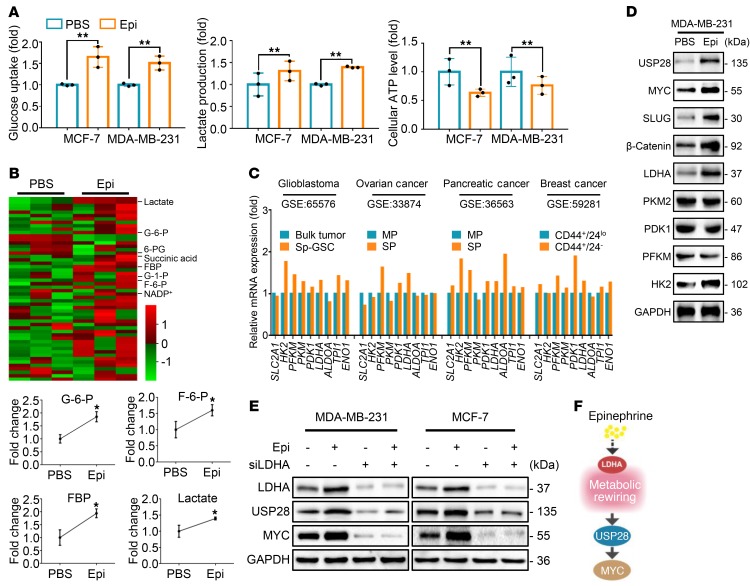
Chronic stress elevates LDHA to enhance glycolysis.(A) Glucose uptake, lactate production, and cellular ATP were measured in MCF-7 and MDA-MB-231 cells treated with PBS or Epi for 5 days; n = 3 (Student’s t test). (B) Representative heatmap of metabolome profiles (top panel). Heatmap colors represent relative metabolite levels as indicated in the color key. Average fold change of glycolytic metabolites was measured by capillary electrophoresis–mass spectrometry (bottom). G-6-P, glucose-6-phosphate; F-6-P, fructose-6-phosphate; FBP, fructose-1,6-phosphate. n = 3 (Student’s t test). (C) Relative mRNA expression of indicated genes in 4 GEO databases analyzed by GEO2R. (D) Immunoblot analysis of MDA-MB-231 cells treated with PBS or Epi for 5 days. (E) Immunoblot analysis of MDA-MB-231 and MCF-7 cells transfected with siLDHA in the presence or absence of Epi for 5 days. (F) Model of Epi-induced USP28/MYC signaling through LDHA-mediated metabolic rewiring. Data are representative of at least 3 independent experiments. Data represent mean ± SEM; *P < 0.05, **P < 0.01.